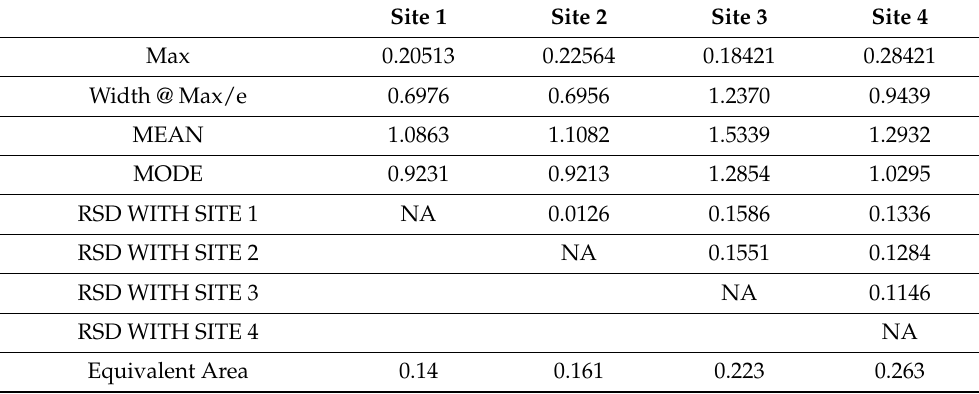
Table 2. Quality of the maximal normalized power as a classifier.